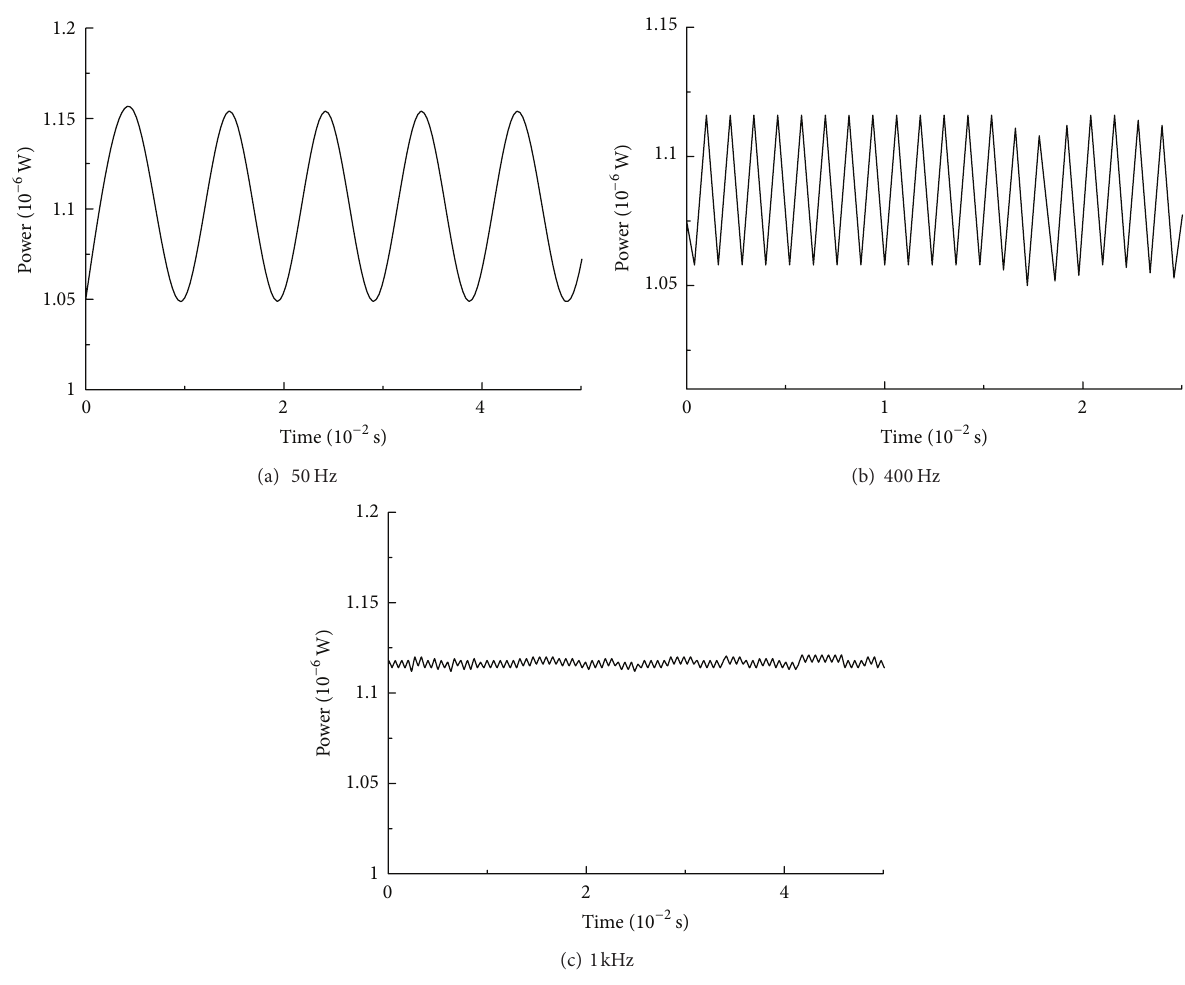
Figure 4: Waveform response of the proposed vibration